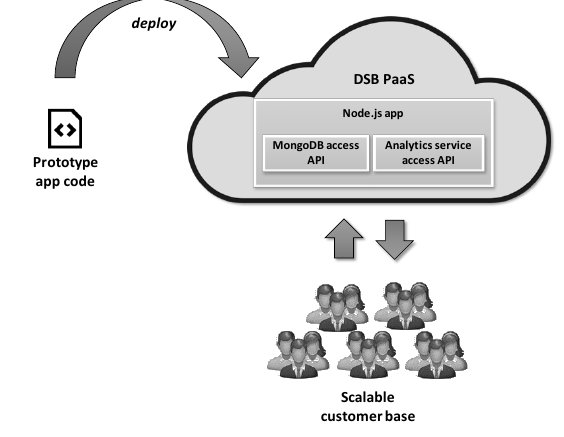
Fig. 7. Sketch with prototype overview created by John and his